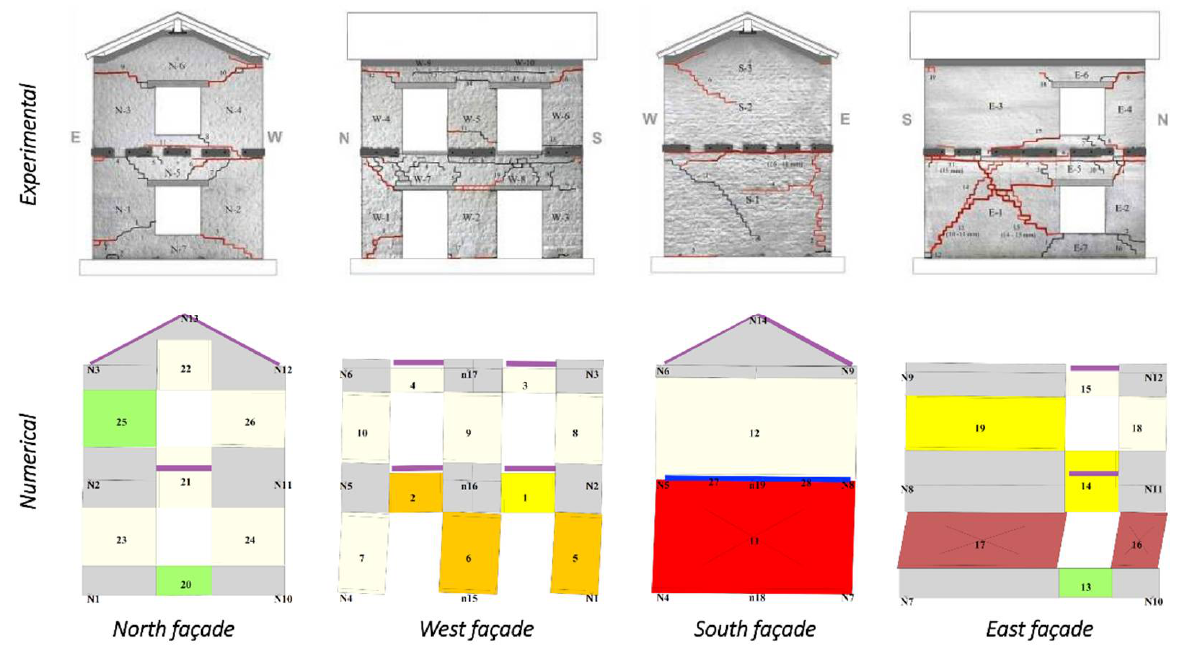
Figure 14. Comparison between experimental and numerical damage patterns for Building 3 (with magnified lateral displacements).